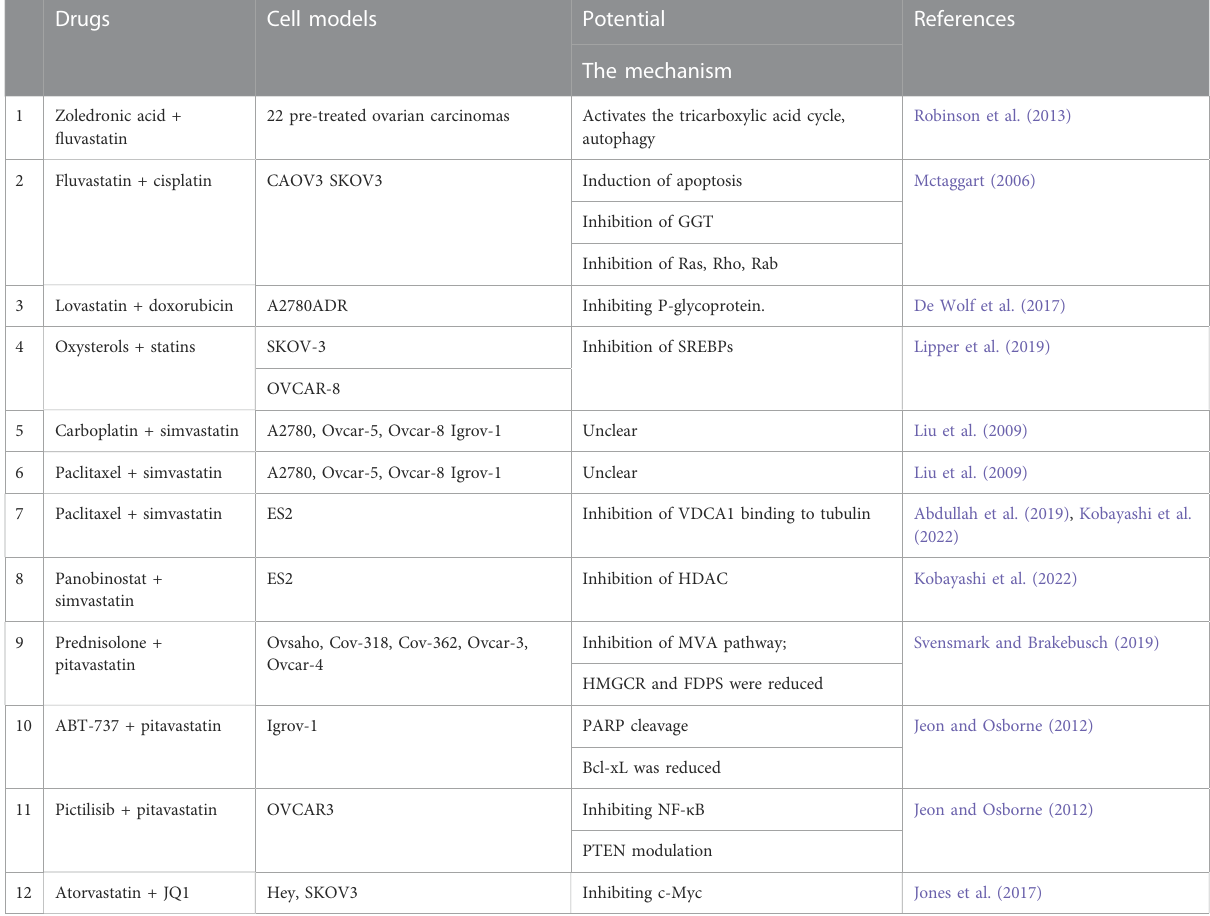
TABLE 1 Synergistic effect of statins with other drugs in the treatment of ovarian